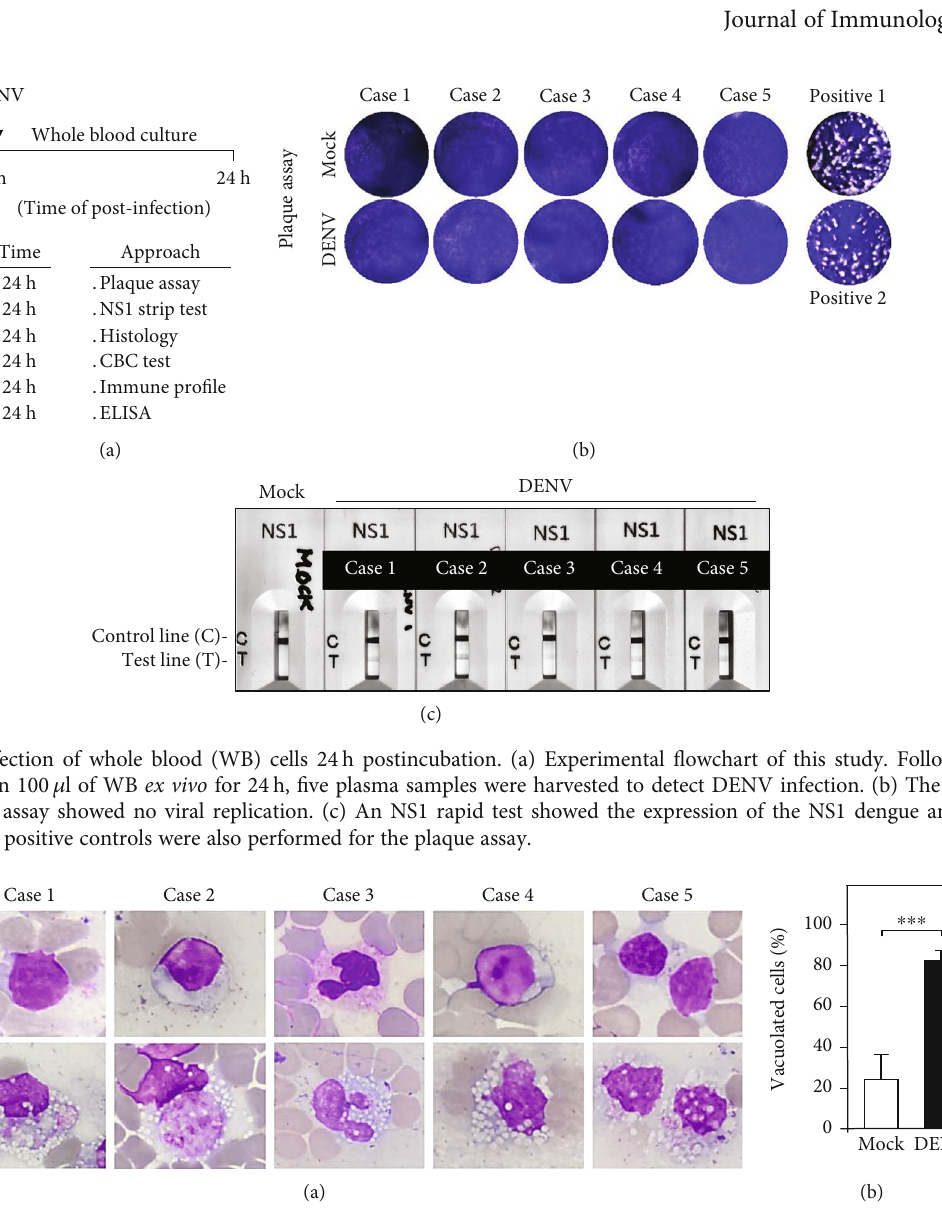
Figure 2: Wright-Giemsa staining images of whole blood (WB) cells 24h postincubation. Following DENV ( MOI = 1 ) coculture in 100 μ l of WB ex vivo for 24 h, Wright-Giemsa staining, shown by an oil immersion fi eld (100x objectives), presented histopathological changes in mononuclear cells (a). The percentages of vacuolated cells are shown (b). The quantitative data are depicted as the mean ± SD obtained from fi ve cases. ∗∗∗ p < 0 : 001 , compared to the mock